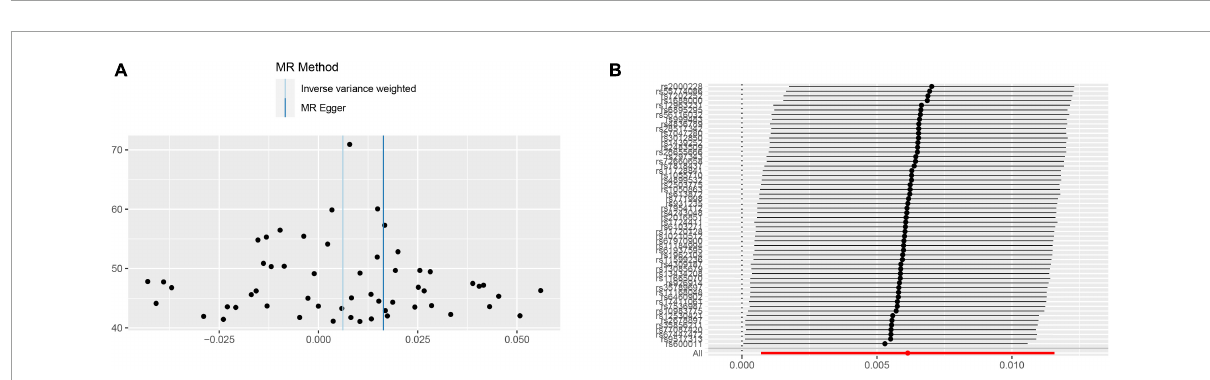
FIGURE5 Sensitivity analyses for mood swings on ICH group. (A) The funnel plot of the causality of mood swings on ICH was symmetrically distributed overall, suggesting that no significant heterogeneity exists. (B) The leave-one-out graph indicated that all lines were located to the right of the “0 line,” indicating that the removal of any SNPs had no fundamental effect on the results, suggesting that the MR results were reliable. ICH, intracerebral hemorrhage; MR, Mendelian randomization; SNP, single nucleotide